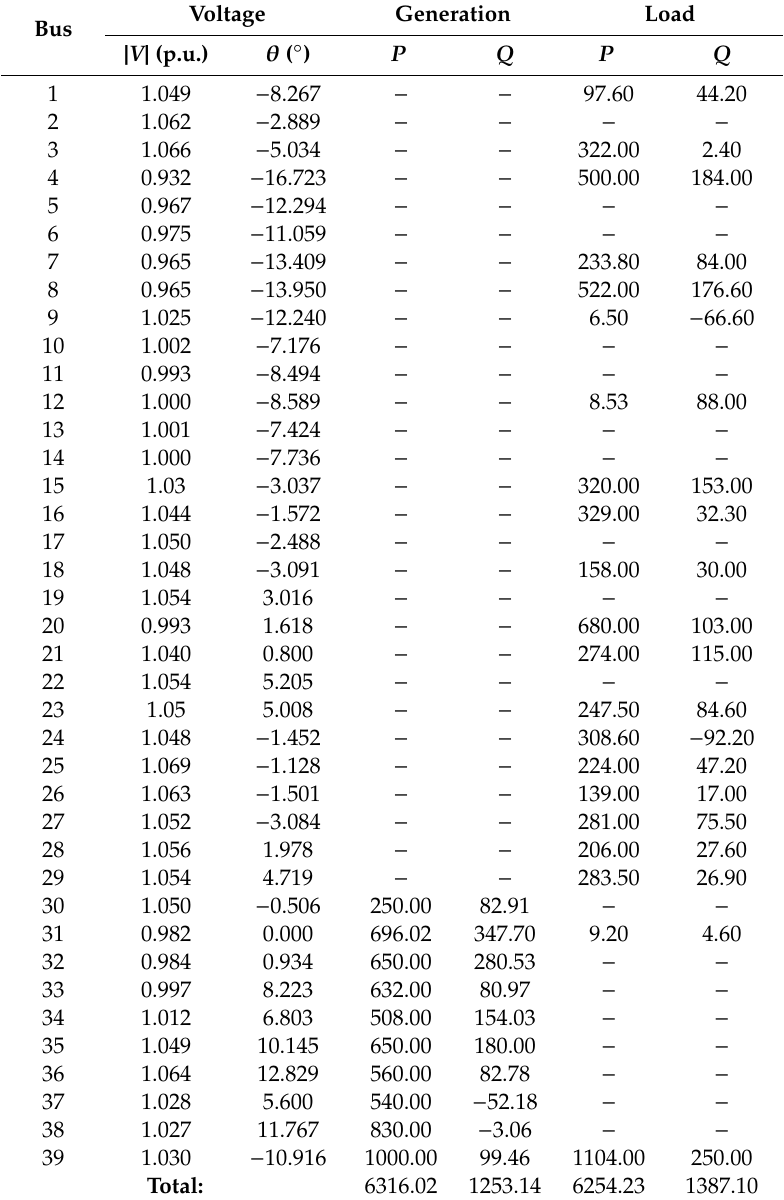
Table A50. Results of Mixed AC / DC PF calculations in Case 7-6. AC bus